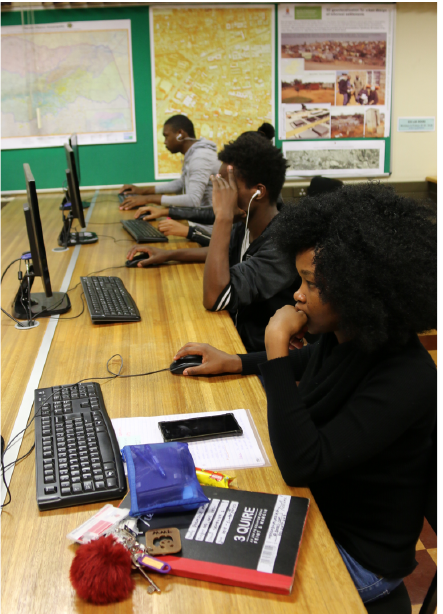
Figure 2. Mapathon participants in action